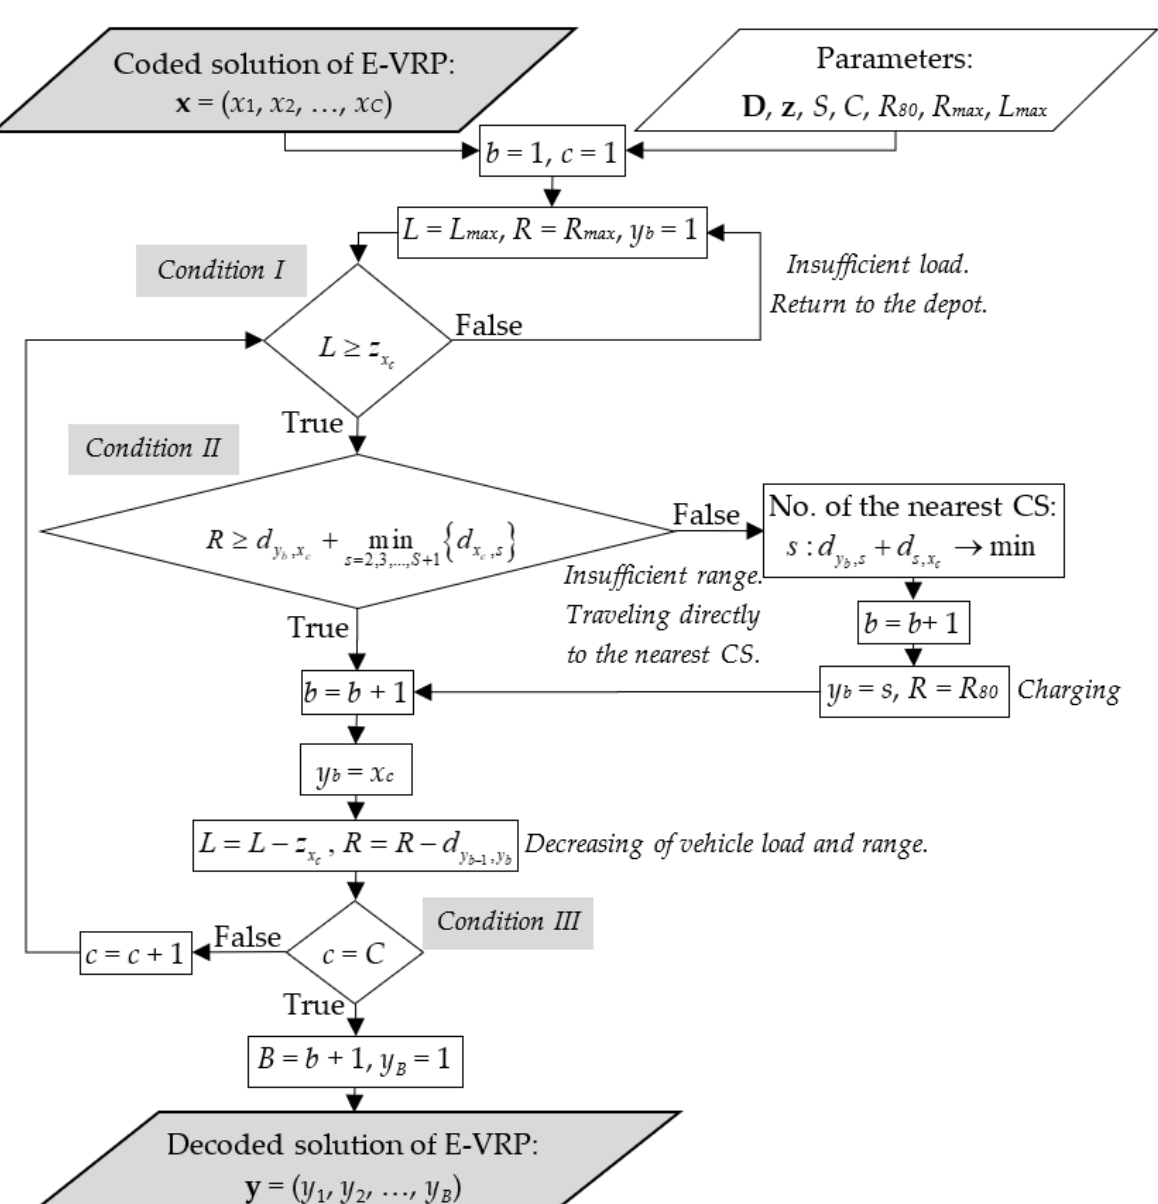
Figure 2. Solution decoding algorithm.